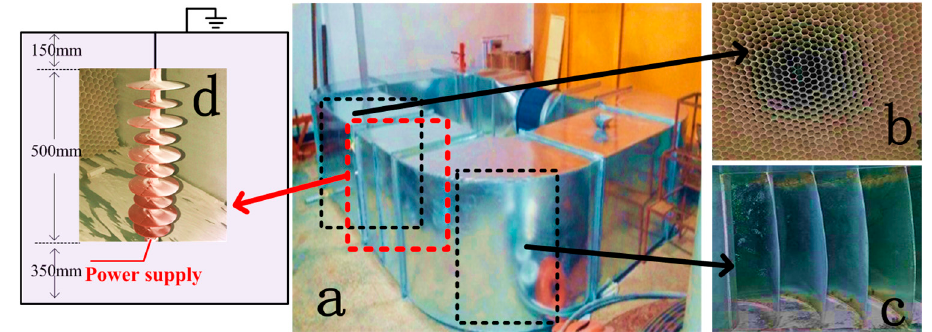
Figure 2. Wind tunnel test devices: ( a ) Wind tunnel; ( b ) six angle cellular; ( c ) deflector; and ( d ) the wind tunnel insulator.